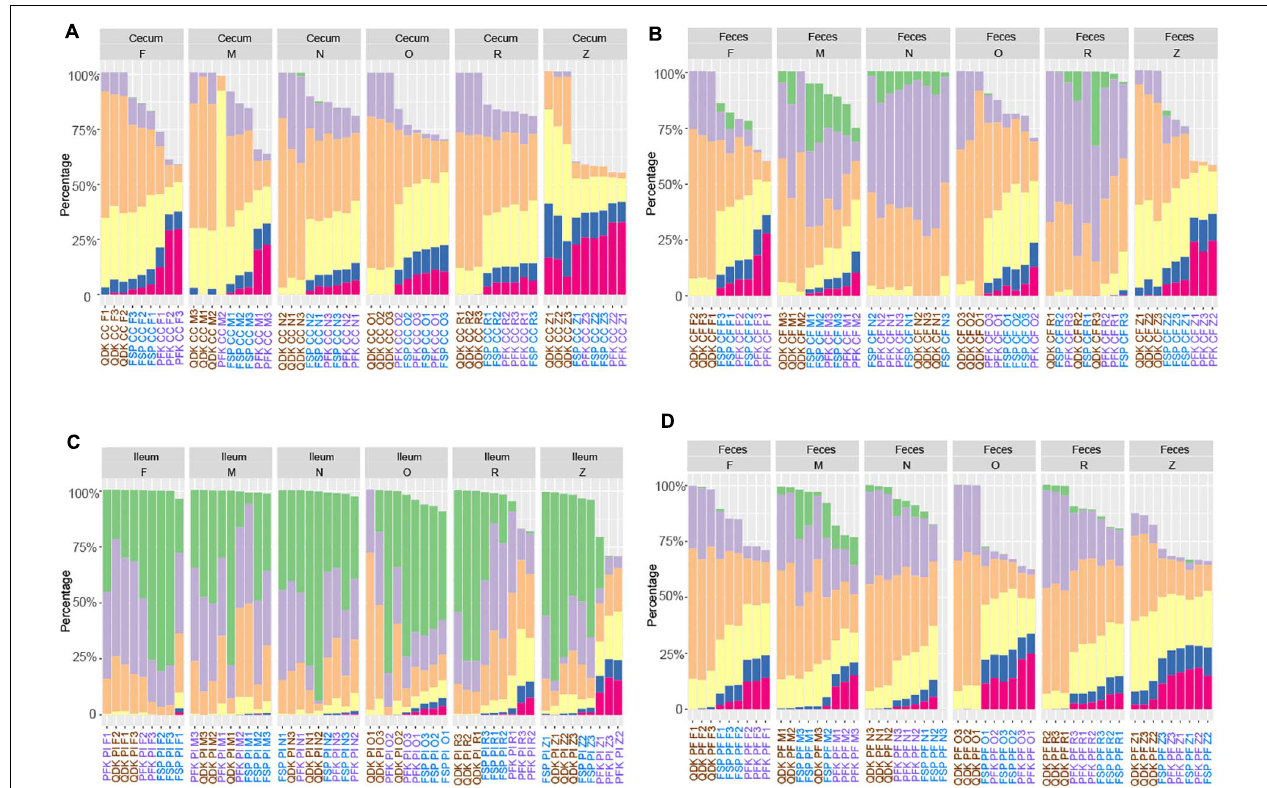
FIGURE 7 | Effect of sample storage on DNA fragmentation profiles using different isolation kits. Chicken cecum (A) and feces (B) DNA, as well as DNA extracted from pig ileum (C) and feces (D) was subjected to analysis via the Fragment Analyzer. The different user-defined size classes are plotted as stacked bars representing % of total DNA. Samples with a DNA concentration below 0.4 ng µ L − 1 were excluded from the